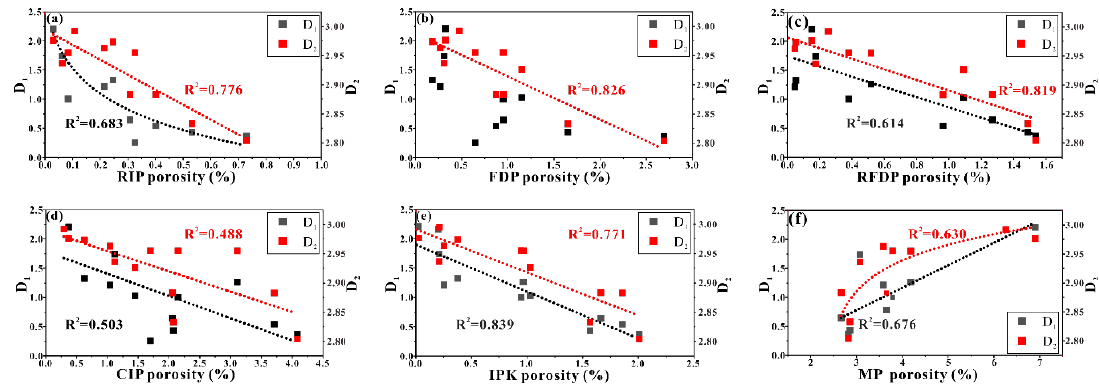
Figure 13. Relationships between fractal dimensions and porosities of different pore types. ( a ) porosity of RIP vs. D 1 and D 2 , ( b ) porosity of FDP vs. D 1 and D 2 , ( c ) porosity of RFDP vs. D 1 and D 2 , ( d ) porosity of CIP vs. D1 and D 2 , ( e ) porosity of IPK vs. D1 and D 2 , and ( f ) porosity of MP vs. D1 and D 2 .